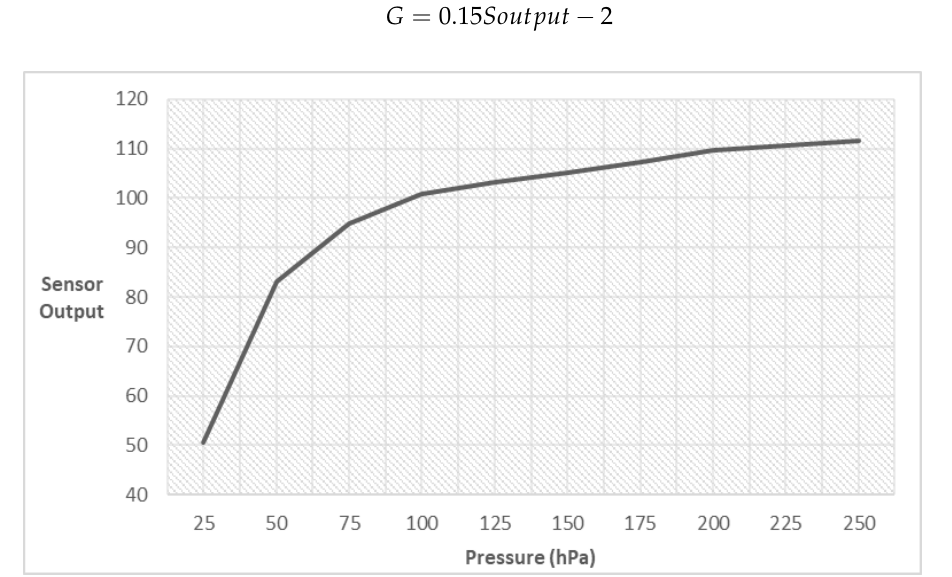
Figure 6. Output of the sensing glove.